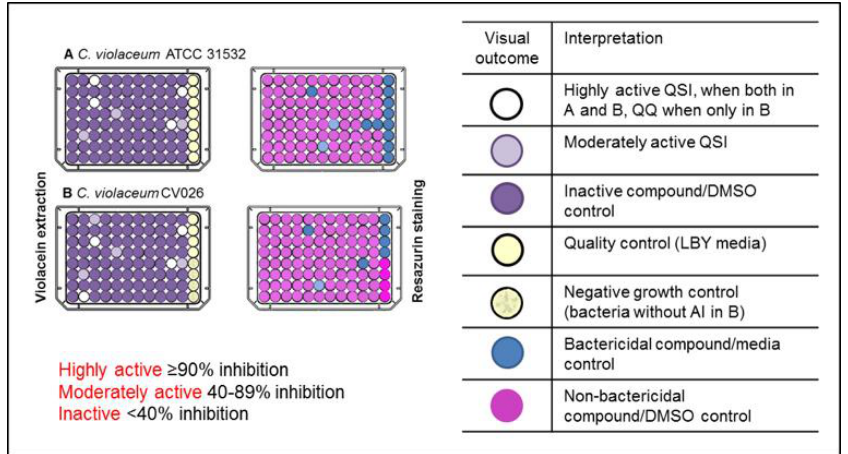
Figure 1. Screening for quorum sensing inhibitors. QSI = quorum sensing inhibitor, QQ = quorum quencher, AI = autoinducer, LBY = Luria–Bertani broth supplemented with yeast extract.